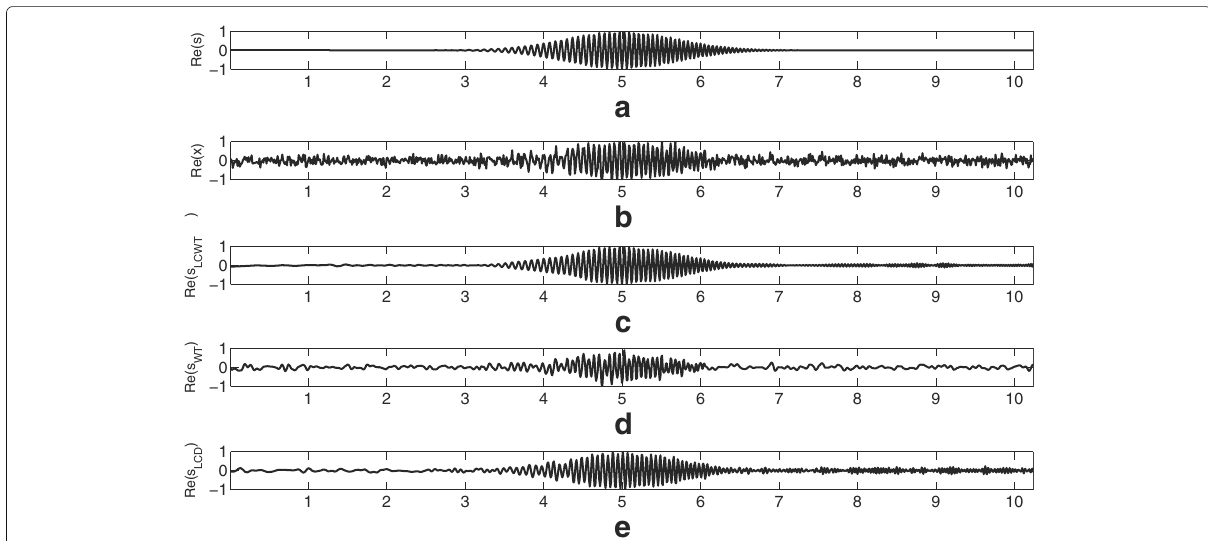
Fig. 13 Comparing different reconstructed signals in the time domain. a The received chirp signal s ( t ) . b The contaminated signal x ( t ) at SNR = 5 dB. c The reconstructed signal of LCWT-based denoising. d The reconstructed signal of WT-based denoising. e The retrieved signal of LCD-filtering